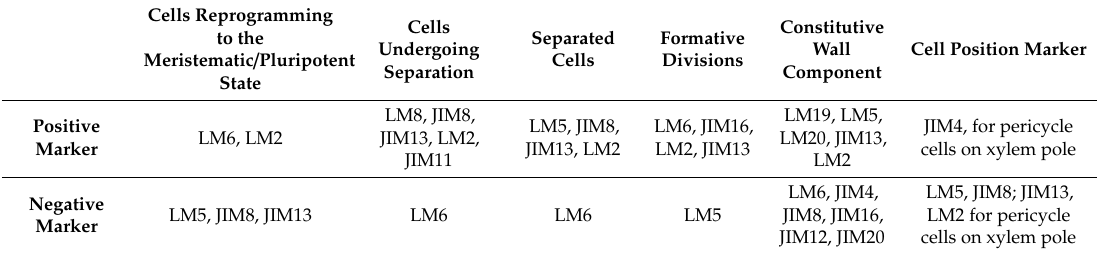
Table 1. The determined positive and negative markers of the cellular events that occurred during the changes of the direction of cell di ff erentiation in a Daucus carota (L.) hypocotyl being cultured on the induction